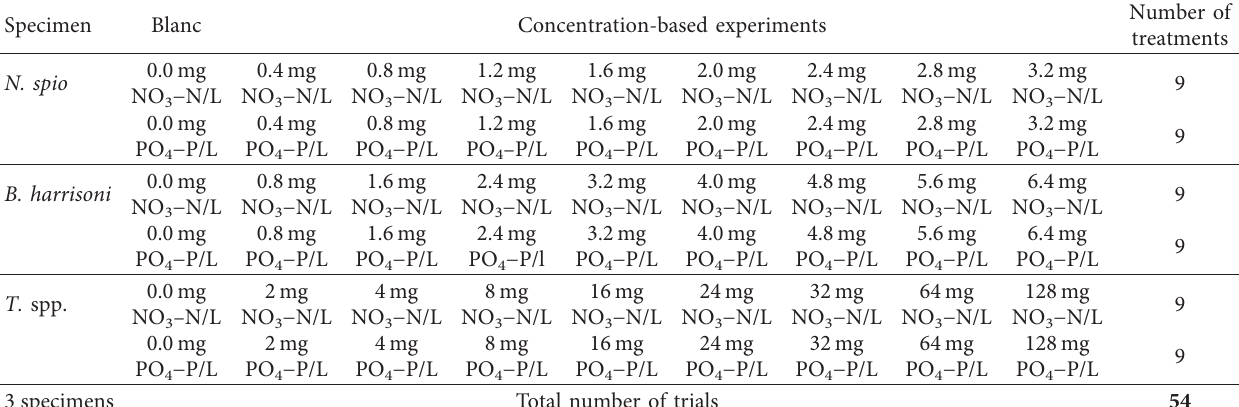
Table 1: Established sites for macroinvertebrates collection along Pangani Basin. Table 2: Number of trials undertaken during static toxicity test.